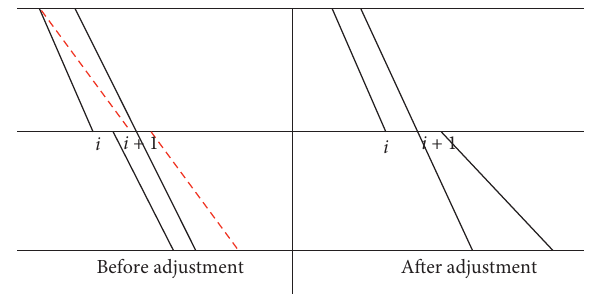
Figure 1: Increasing the overtaking.